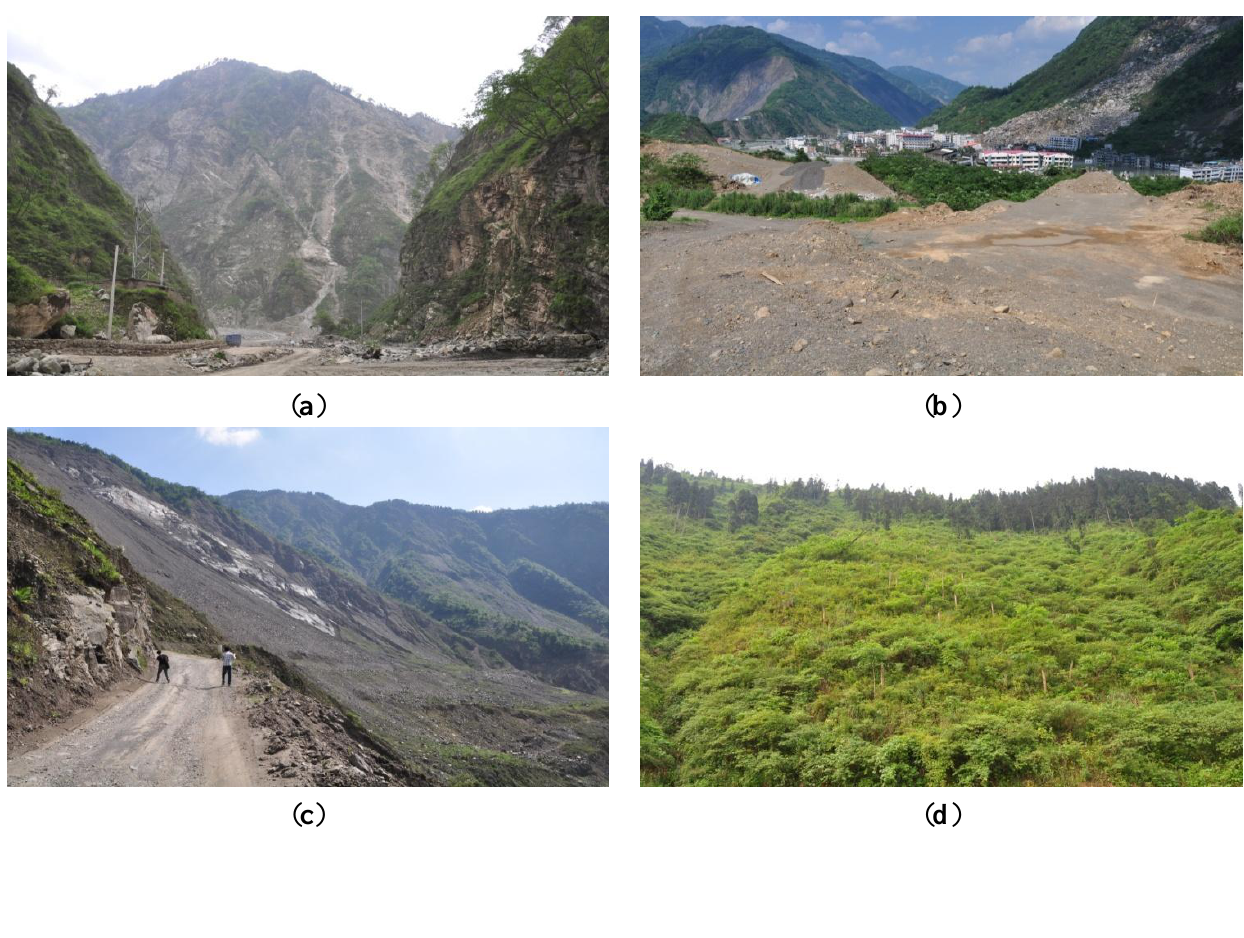
Figure 3. Photos taken at geologic hazard sites during the field investigation in May